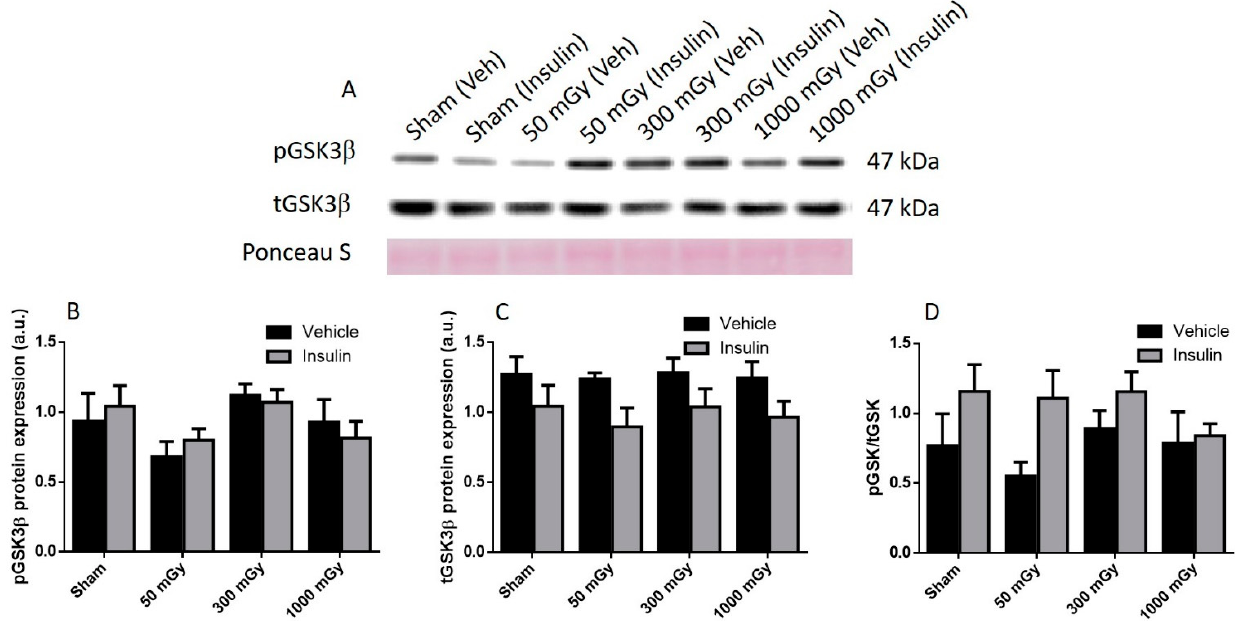
Figure 5. Representative western blot ( A ) and quantified band density (relative protein expression in arbitrary units) for phosphorylated GSK3 β (pGSK3 β ) ( B ), total GSK3 β (tGSK3 β ) ( C ), and the ratio of phosphorylated protein to total protein ( D ) in male offspring hearts. Results were normalized to loading controls (samples repeated on each gel) to account for differences between gels, and Ponceau S staining was used as a marker of equal protein loading. Data are presented as a mean ± SEM. n = 11–13 per group.